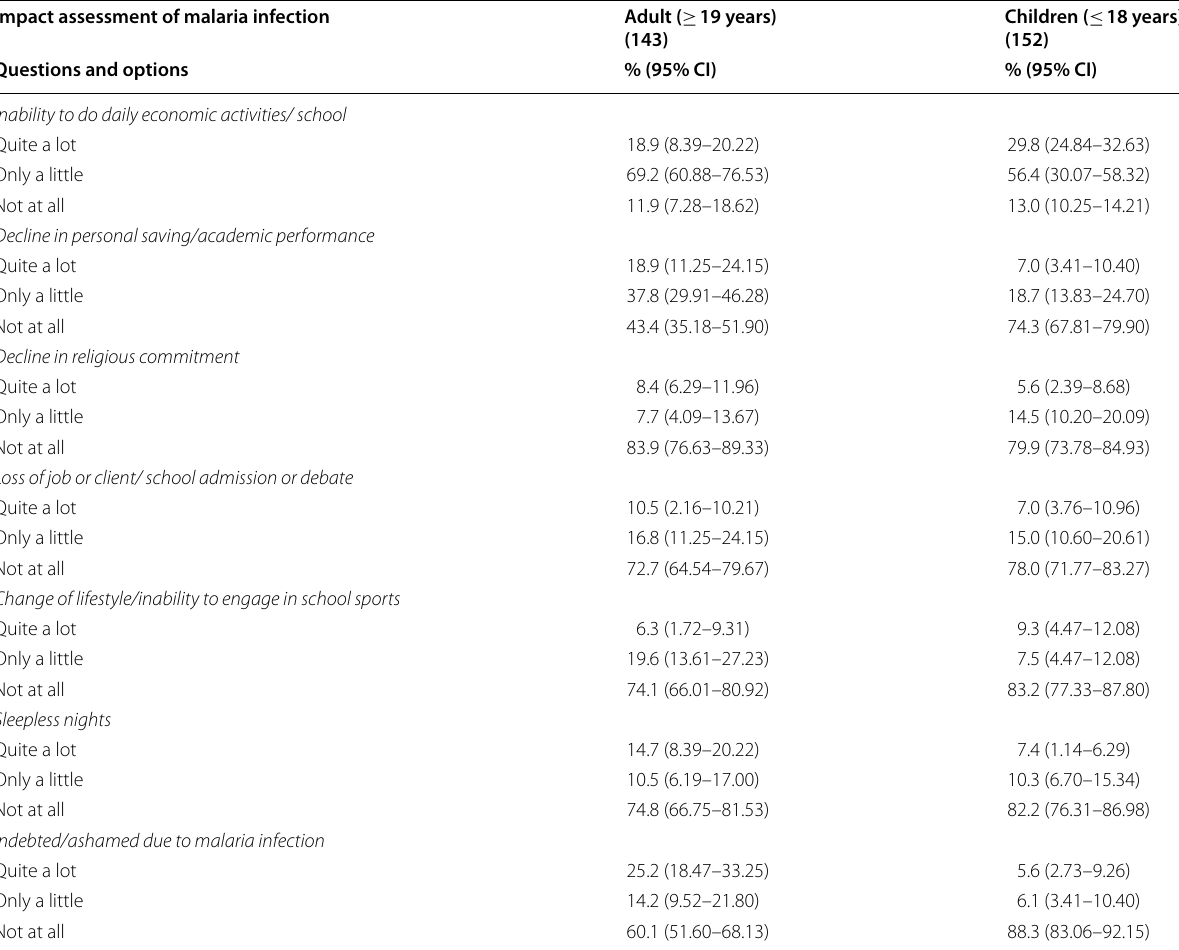
Table 3 Impact assessment of malaria infection on socioeconomic activities of children and Adult Impact assessment of malaria